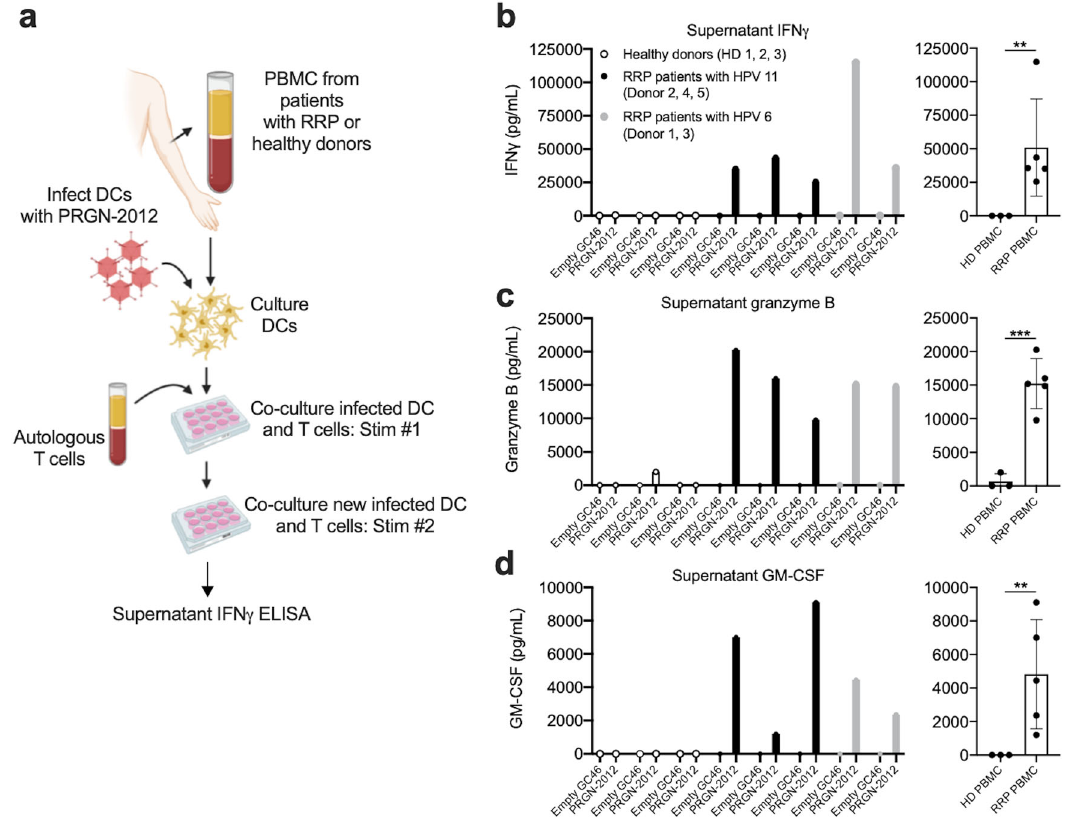
Fig. 1 In vitro stimulation with PRGN-2012 induced HPV antigen-speci fi c responses in T cells from RRP patients. a Experimental design of in vitro stimulation of T cells isolated from the blood of patients with HPV6 or HPV11-driven RRP or healthy donors with PRGN-2012. Concentrations of b IFN γ , c granzyme B, and d GM-CSF in the supernatant of cocultures assessing HPV antigen-speci fi c responses in T lymphocytes isolated from the blood of patients with HPV11-driven RRP ( n = 3, black bars), HPV6-driven RRP ( n = 2, gray bars), or healthy donors ( n = 3, open bars) following two rounds of in vitro simulation with PRGN-2012 or empty GC46. Displayed results are the result of HPV antigen-speci fi c stimulation after baseline cytokine concentrations following in vitro stimulation with empty GC46 were subtracted. Similar results were observed in two independent assays. PBMC peripheral blood mononuclear cells, DC dendritic cells, HD healthy donor, empty GC46 GC46 gorilla adenovirus without HPV gene inserts (control virus). ** p < 0.01; *** p < 0.001; Student ’ s t